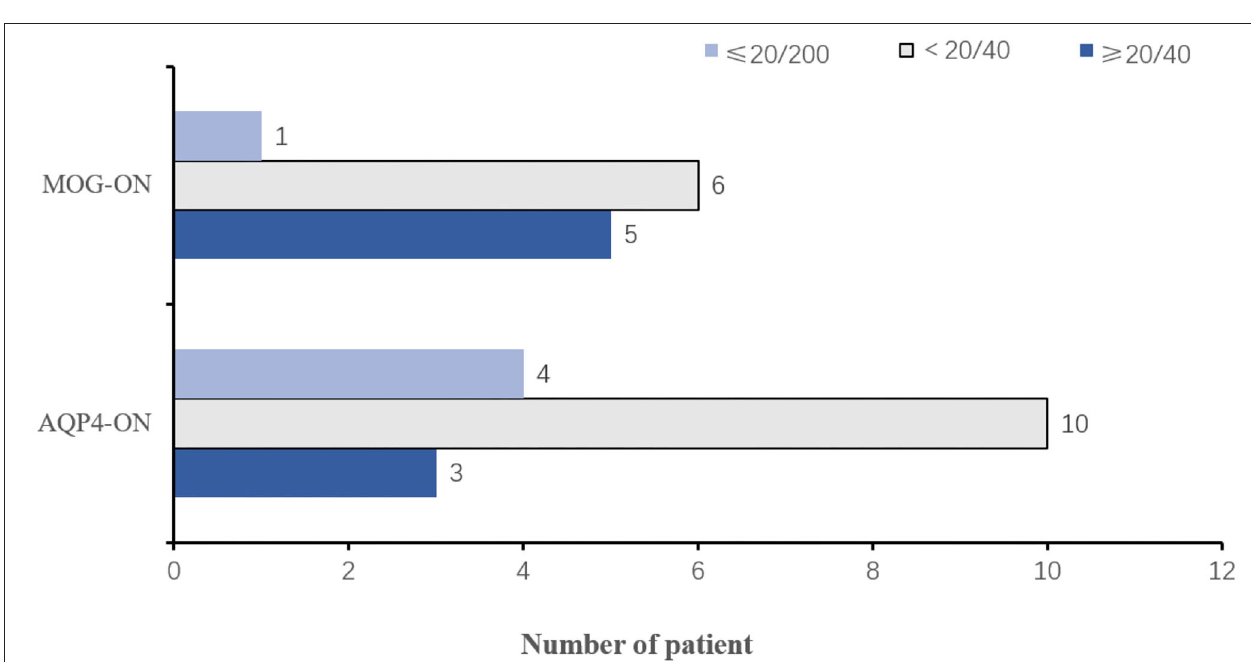
FIGURE 3 | V1 and brain volume in patients and HCs. Boxplot of V1 (A) and brain volume (B) in MOG-ON (left, white), HCs (middle, light blue), and AQP4-ON (right, dark blue). V1, primary visual cortex volume; brain volume, whole brain volume including gray matter and white matter; HC, healthy control; MOG-ON, optic neuritis patients with MOG antibody; AQP4-ON, NMOSD patients with AQP4 antibody positive and a history of ON; OR, optic neuritis.